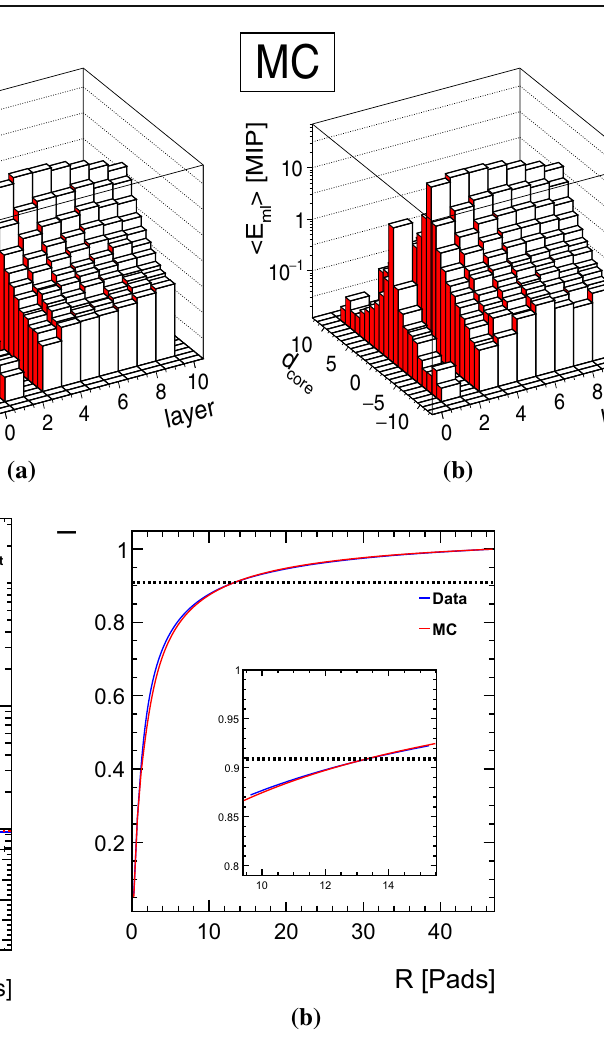
fitted function, for the data (blue) and the MC (red). b The integral on F E ( r ), I , that was extracted from the fit in ( b ). The insert in ( a ) shows an expanded view of the region 10 < R < 15